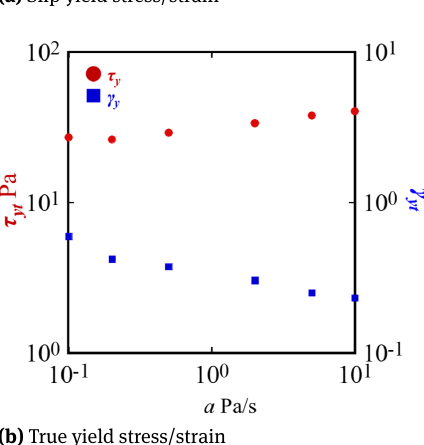
Figure 11: Stress–strain curves from the stress-ramp test. (a) Slip yield stress and (b) true yield stress